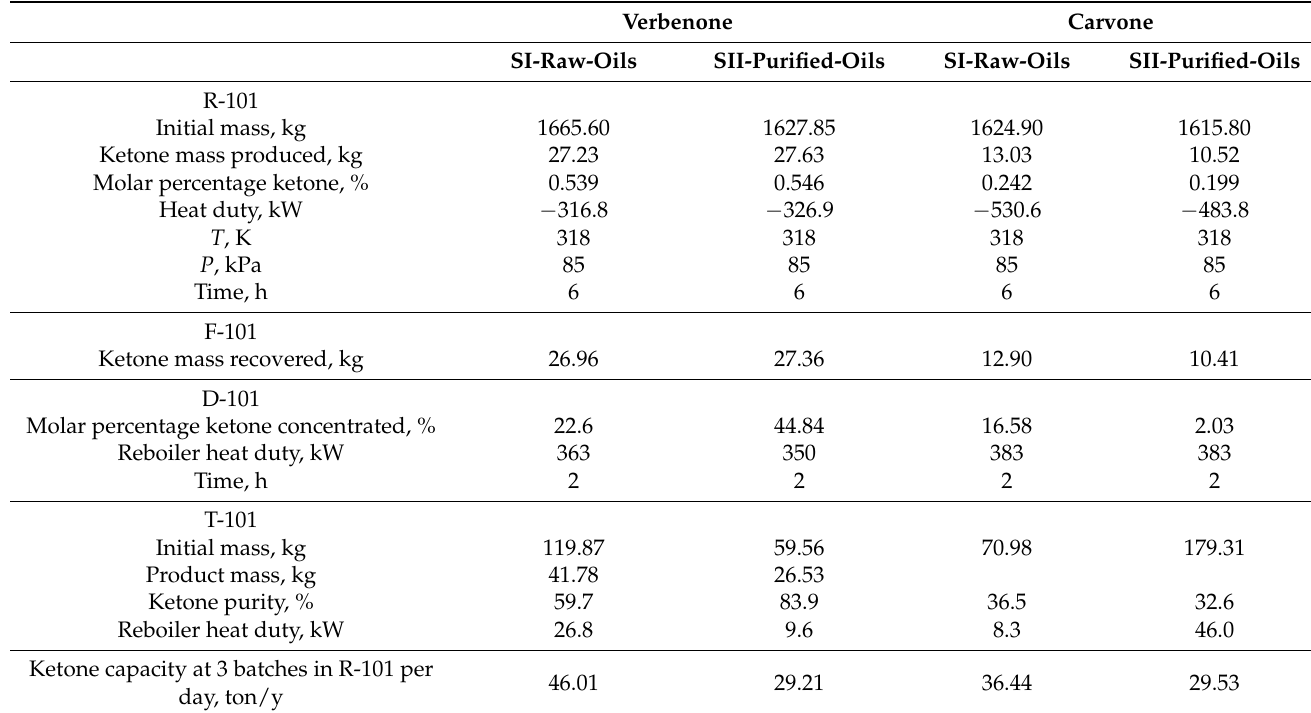
Table 1. Design parameters of the proposed scenarios in the conceptual process for the production of verbenone and